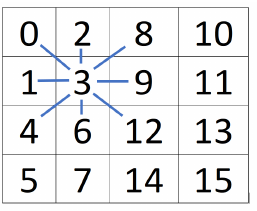
Figure 6. Layout of base